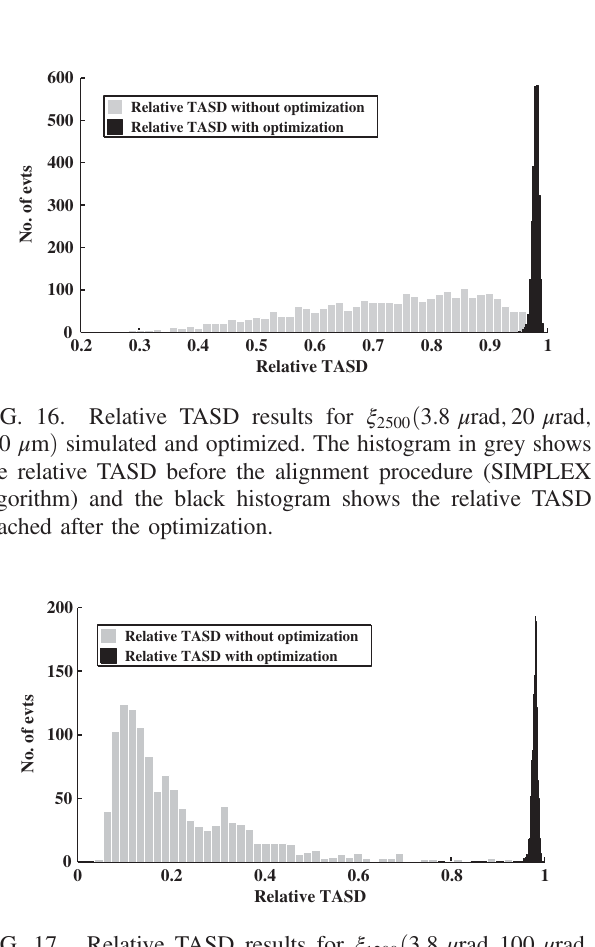
FIG. 17. Relative TASD results for ξ 1200 ð 3 . 8 μ rad ; 100 μ rad ; 100 μ m Þ simulated and optimized. The histogram in grey shows the relative TASD before the alignment procedure (SIMPLEX algorithm) and the black histogram shows the relative TASD reached after the